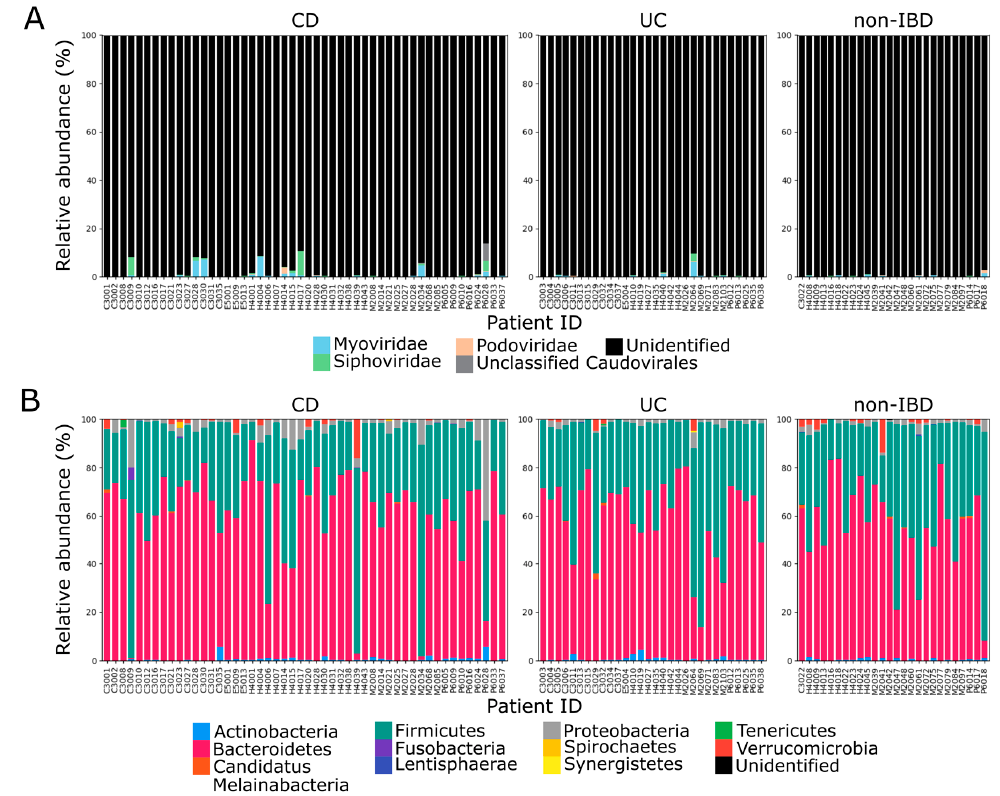
Figure 1. Relative abundance of gut microbes and viruses in inflammatory bowel disease (IBD) and non-IBD patients. Mean relative abundance within each patient is plotted at the family level for temperate bacteriophages ( A ) and at the phylum level for bacteria ( B ). Relative abundance was calculated based on genome length normalized read counts.